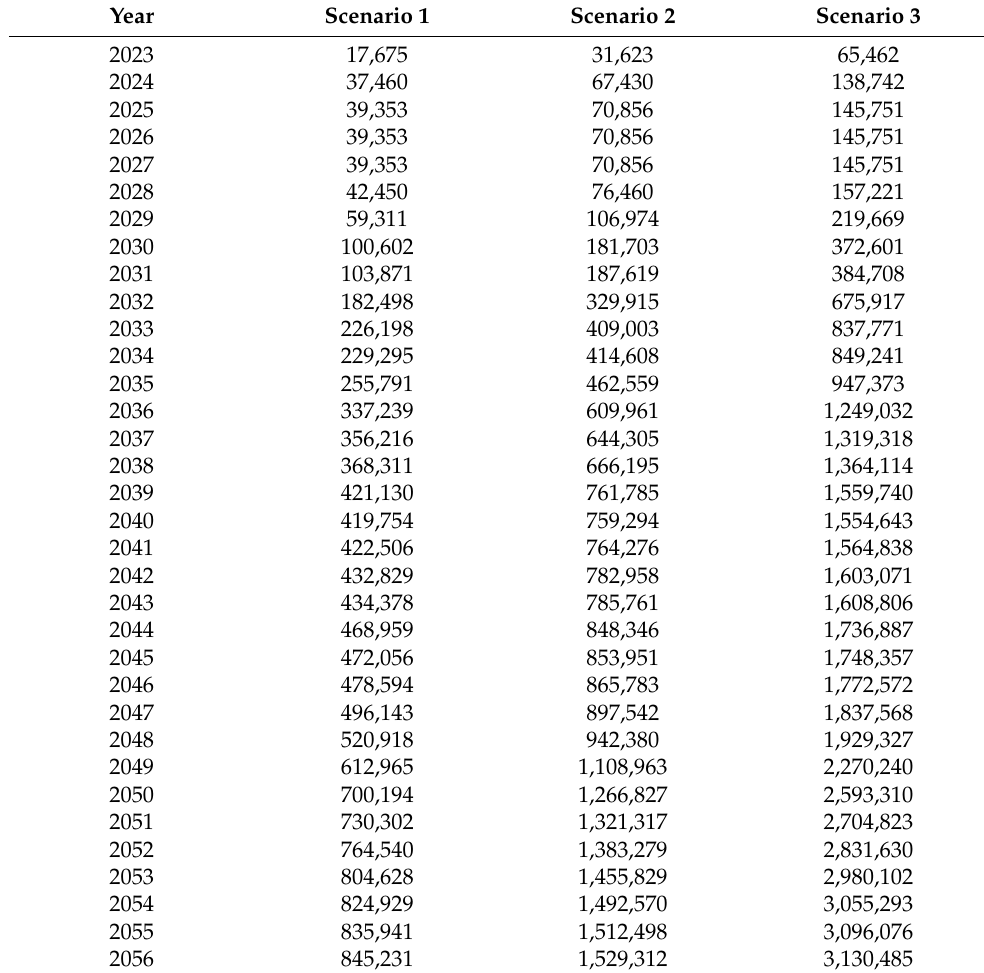
Table 9. Expected cumulative construction cost of hydrogen pipelines by year based on